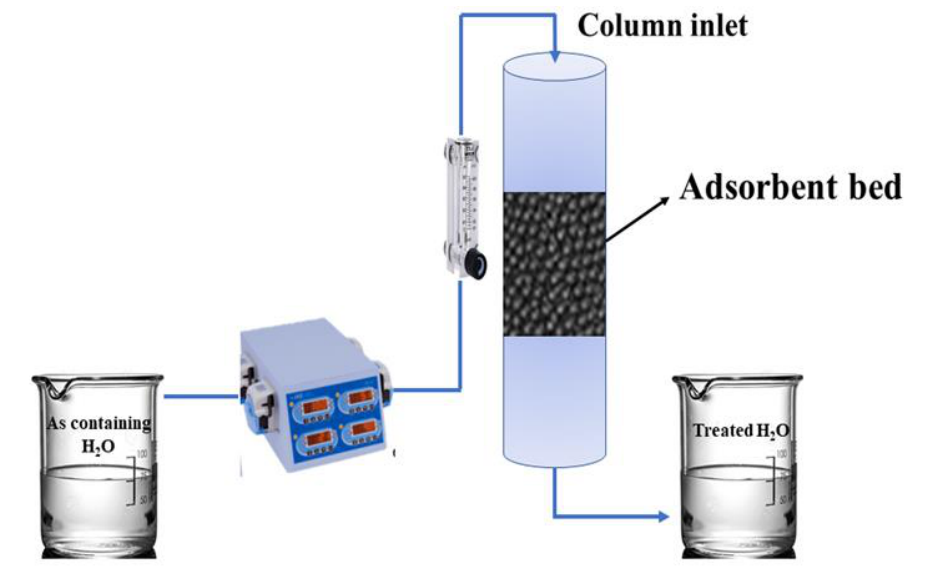
Figure 1. Schematic representation of the experimental setup.